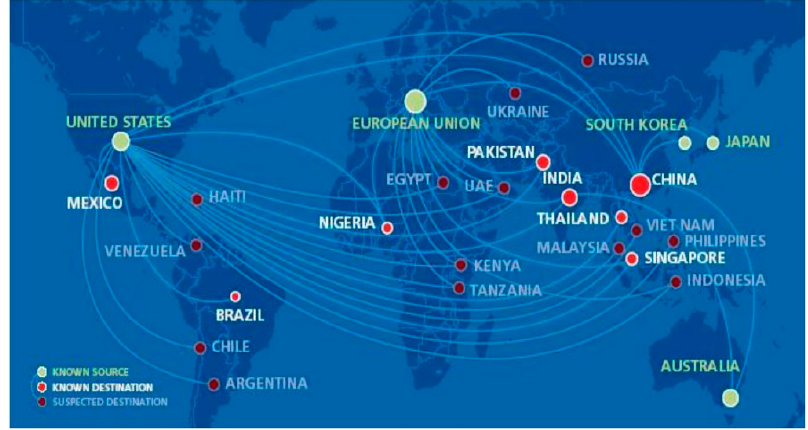
Figure 4. Hazardous Waste Illegal Routes. Source: [38,39].